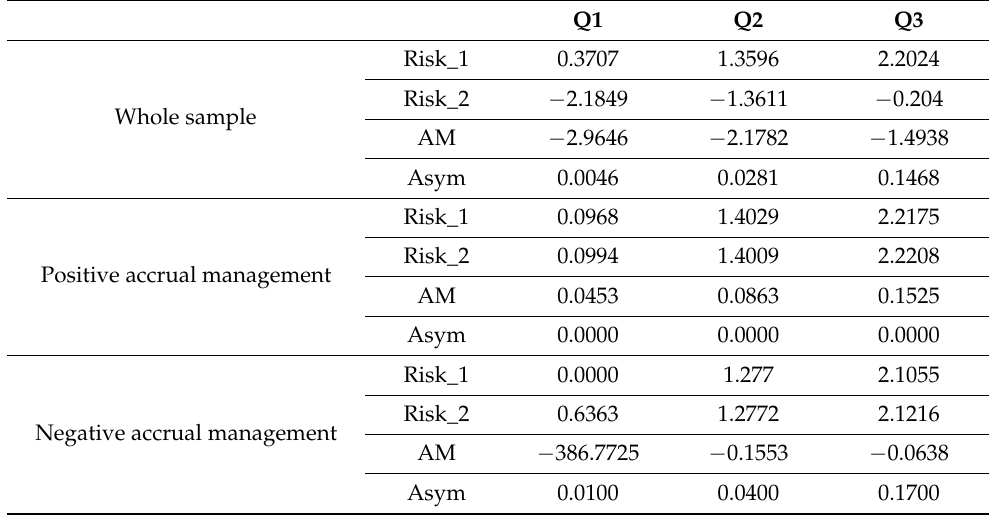
Table 3. Accrual Management, Information Asymmetry, and Firm-Specific Risk.